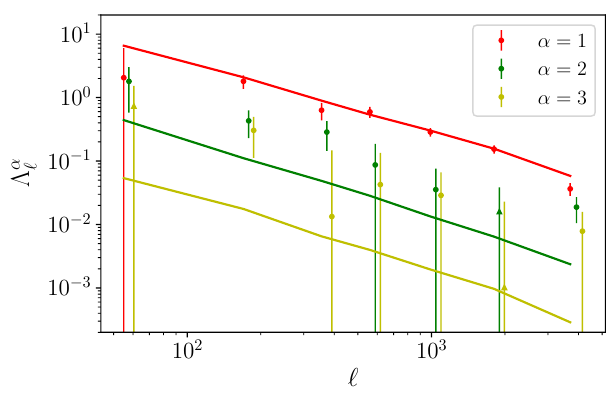
Figure 11. Measured power spectra for the first three KL eigen- values as a function of angular scale (cid:96) (points with error bars), to- gether with their theoretical prediction for the fiducial cosmological parameters used in our analysis. Most of the signal is contained in the first eigenvalue, with all other modes being significantly noise- dominated.